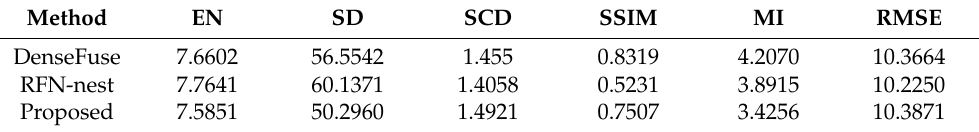
Table 6. Quantitative evaluation of images in the third column in Figure 8. This table only shows the comparison between the proposed method and DenseFuse and RFN-Nest which have good performance.